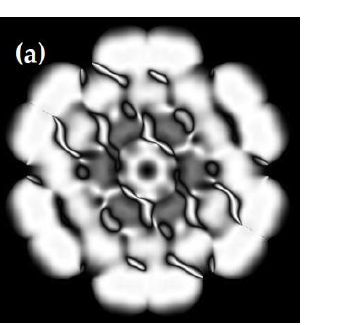
Figure 2. Examples of the training data for the Golay-6 system, based on the Alternative Metrics carried by the same pistons: ( a ) the Power Metric (PM); ( b ) the Sharpness Metric (SM); ( c ) the Double-defocused Sharpness Metric (DSM).